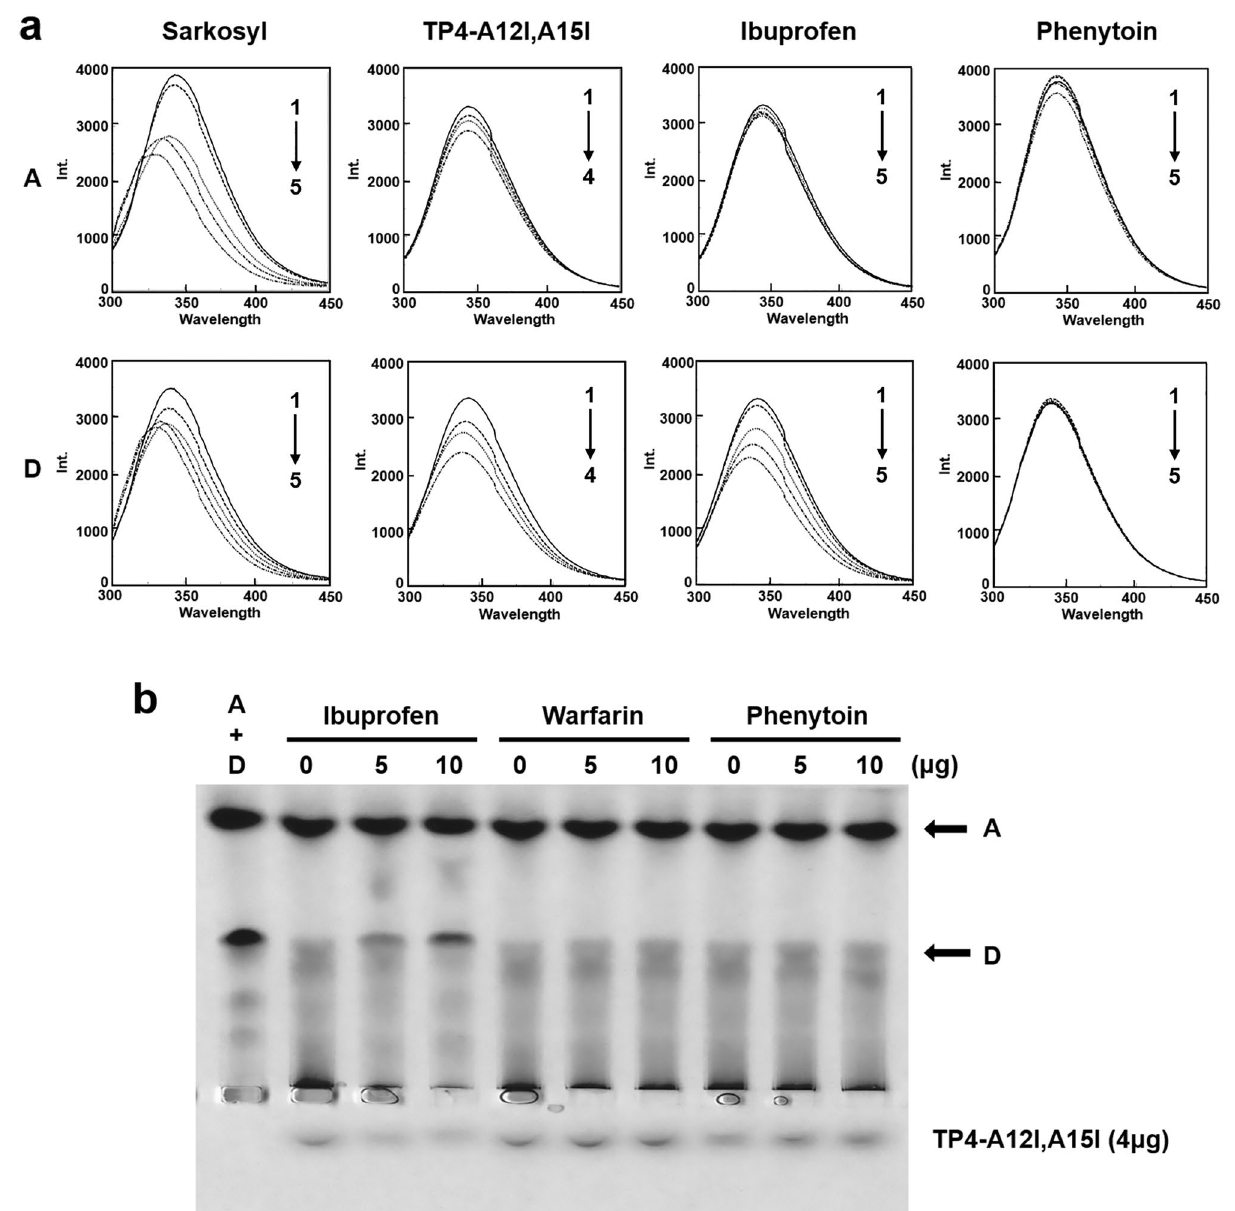
Figure 7. Binding of TP4-A12I,A15I peptides and drug to protein D. ( a ) Emission spectra of proteins A and D in the presence of sarkosyl, TP4-A12I,A15I, Ibuprofen and Phenytoin. Reagents were added to the protein A and protein D at the indicated concentrations and excited at 280 nm and recorded for the emission spectrum between 300 to 450 nm. Protein A and D: 0.75 μM each; Sarkosyl: lines 1–5 at 0, 5, 20, 80 and 320 μM; TP4- A12I, A15I: lines 1 to 4 at 0, 30, 60, 120 μM; Ibuprofen; lines 1 to 5 at 0, 3, 6, 12 and 24 μM; Phenytoin; lines 1 to 5 at 0, 2.5, 5, 10 and 20 μM. ( b ) Inhibition of the binding of TP4-A12I,A15I to protein D by Ibuprofen. The protein A and D mixture (20 μg each) was pre-incubated with Ibuprofen, Warfarin or Phenytoin for 30 min before incubating with TP4-A12I,A15I (4 μg) at 37 °C for 30 min, and analyzed by native PAGE,